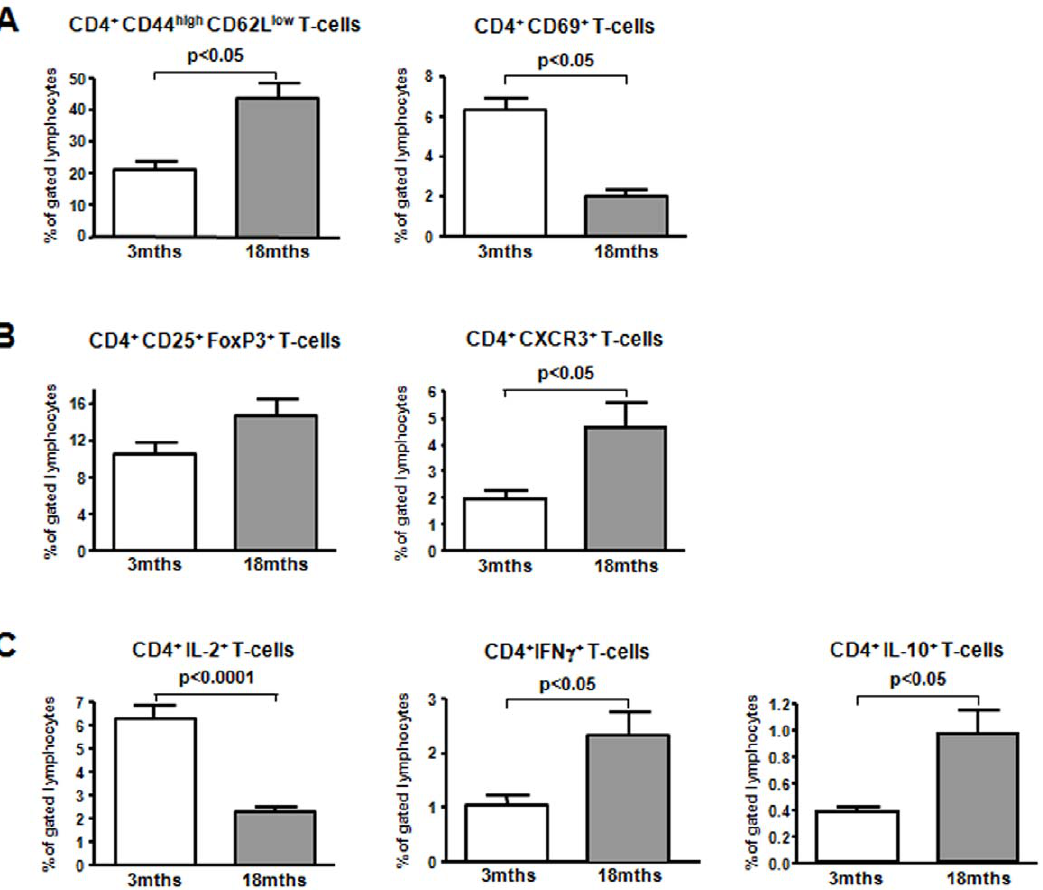
Figure 5. Impaired T-cell activation and proliferation in aged WT recipients. Impaired T-cell activation and proliferation of splenocytes of aged WT transplant recipients. 3 and 18mths old WT recipients of bilateral bm12 skin grafts were sacrificed by day 7 and splenocytes were re- stimulated with PMA/Ionomycin for 4hrs. Following surface staining (CD4, V a 2.1 and V b 8.1) cells were permeabilized and stained with PE-conjugated anti-IFN c , IL-2 or IL-10 mAbs and isotype control mAbs. Early activated CD4 + T-cells were reduced in frequency in older animals ( A ) while effector/ memory CD4 + T-cells and regulatory CD4 + T-cells accumulated. ( B ) Despite a reduced functional in vitro and in vivo response as indicated by impaired IL-2 production expression of proinflammatory cytokines is elevated with age at day 7 after restimulation ( C